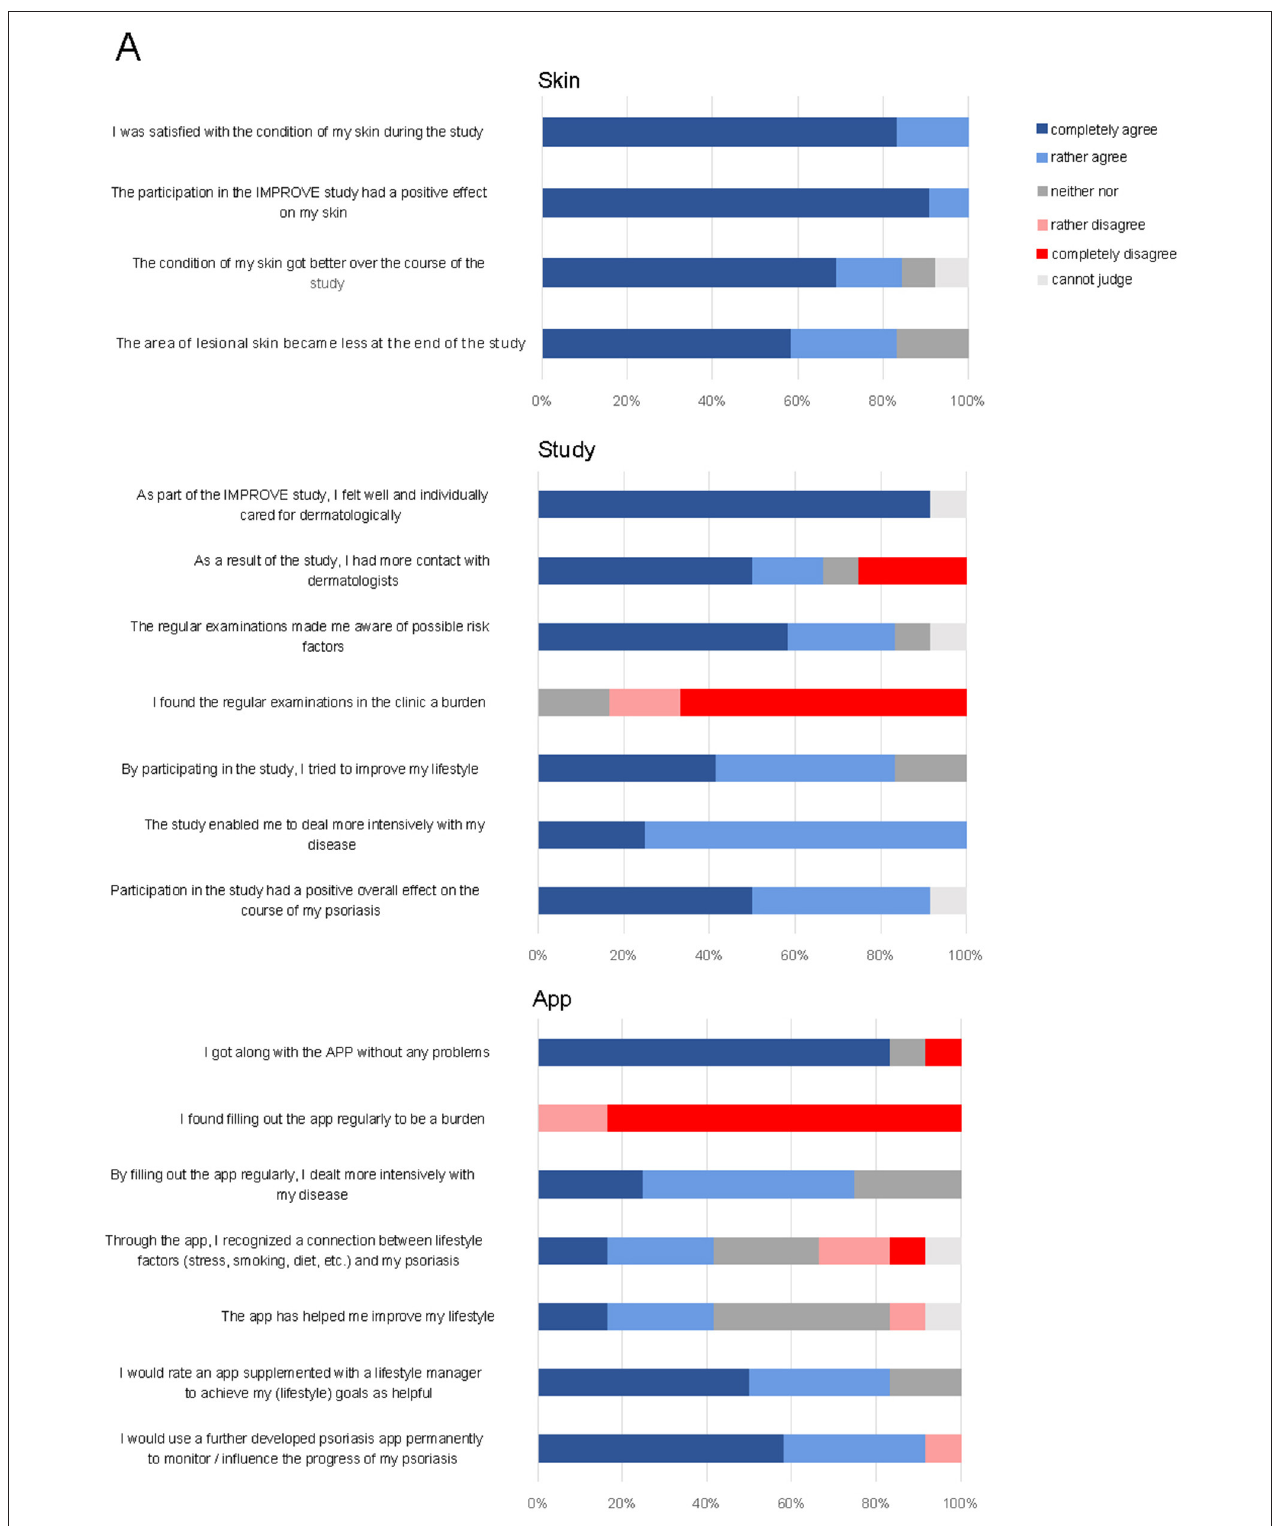
FIGURE 4 | Final questionnaire at the end of the study on skin, study design, and app. Shown are patients’ responses in percent on a verbal rating scale.